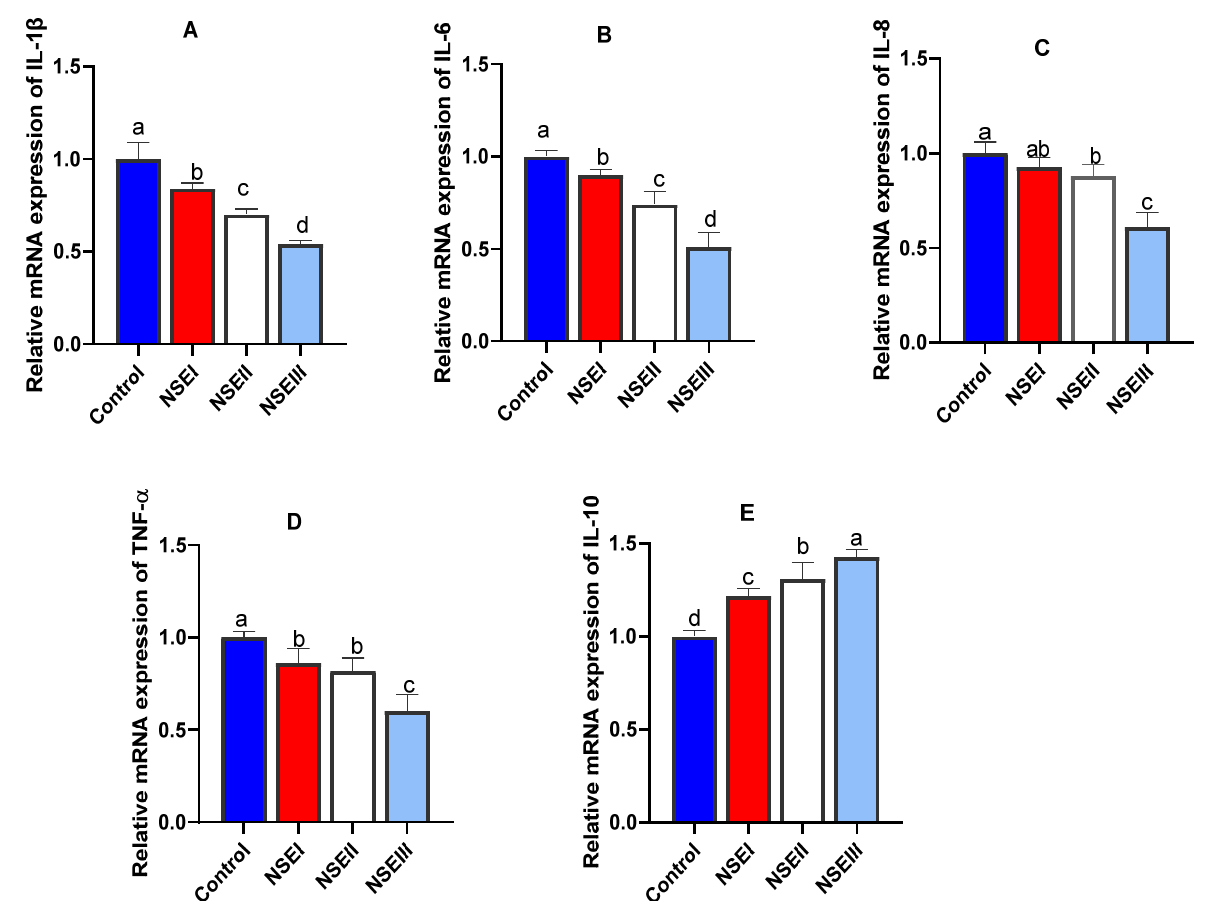
Figure 2. Relative mRNA expression levels of interleukin ‐ 1 β IL ‐ 1 β , ( A ), IL ‐ 6 ( B ), IL ‐ 8 ( C ), tumor necrosis factor ‐ alpha TNF ‐α , ( D ) and IL ‐ 10 ( E ) detectable by qRT ‐ PCR in the splenic tissues of rab ‐ bits fed various levels of N. sativa oil extract (NSE) at 60 d of age. Values represent means with their SE in bars. Control: rabbits offered the basal diet, NSEI, NSEII and NSEIII: rabbits fed graded levels of NSE comprising 125, 250 and 500 mg/kg diets, respectively. a–d Means carrying different super ‐ script letters indicate statistical significance ( p < 0.05).